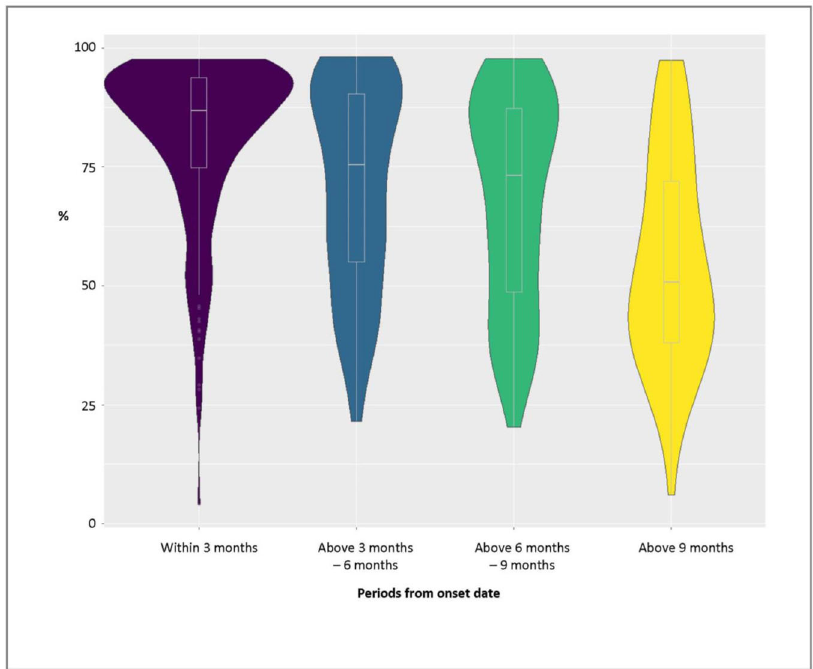
Fig. 2 Distribution of neutralising antibody (NAb) levels in % by surrogate virus neutralisation test (sVNT) in different periods from the onset date, among 490 measurements in 200 patients. Violin plot with box plot (light grey marker for median and box for interquartile range) showing the distribution of neutralising antibody (NAb) levels in % by periods from the onset date: within 3 months (208 measurements), above 3 months – 6 months (110 measurements), above 6 months – 9 months (99 measurements), and above 9 months (73 measurements); note: 1 patient may have more than one measurement in the same